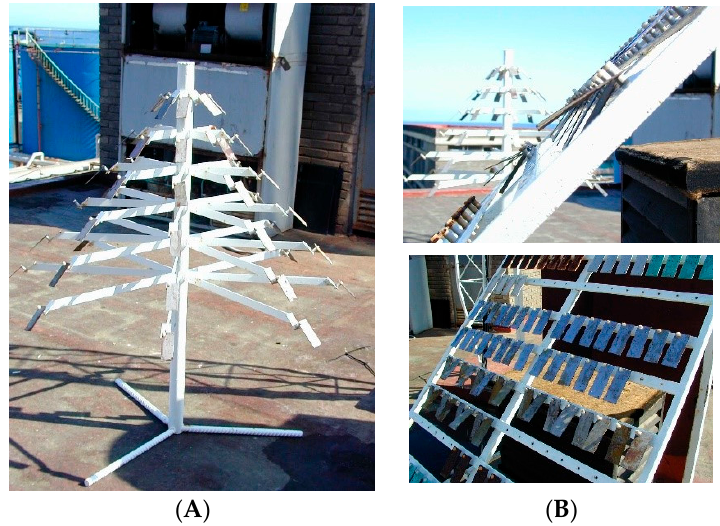
Figure 1. Metallic frames employed to expose the carbon steel panels for the investigation of the influence of ( A ) the orientation and ( B ) the exposure angles on the atmospheric corrosion rate. Table 2. Composition of the carbon steel. Composition (wt. %)